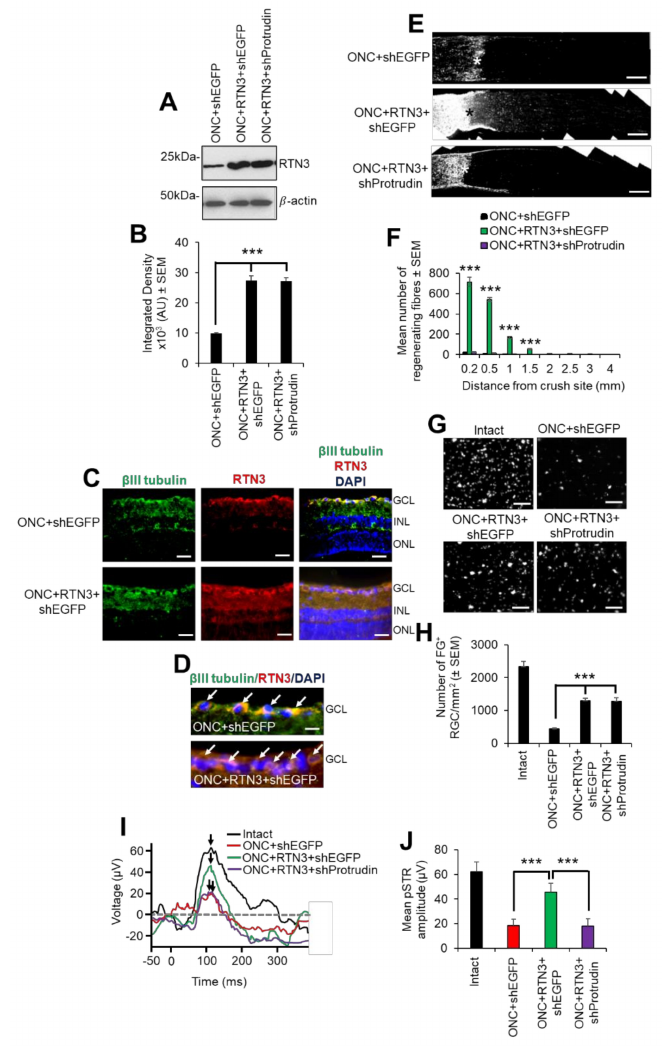
Figure 8. RTN3 overexpression promotes RGC axon regeneration and functional recovery after ONC, which is also protrudin-dependent. ( A ) Western blot and ( B ) quantification to show that RTN3 plasmids significantly upregulate RTN3 protein in the retina after intravitreal injection in vivo. ( C ) Immunohistochemistry to localise RTN3 protein to the RGCs (green) in the ganglion cell layer (GCL) and the inner plexiform and inner nuclear layer (INL). ONL = outer nuclear layer. ( D ) High power images to show RTN3 protein localised to β III-tubulin + RGCs (arrows) in the GCL. ( E ) GAP43 immunohistochemistry and ( F ) quantification to show that in control optic nerve, few if any GAP43 + axons pass beyond the lesion site (*) whilst in RTN3 overexpressed eyes, significant GAP43 + axons are present beyond the lesion site, an effect which is obliterated when Protrudin is knocked out at the same time as RTN3 overexpression. ( G ) Representative images to show FluorGold (FG) backfilled RGC in retinal wholemounts after RTN3 overexpression. ( H ) Quantification of the number of FG + RGC in retinal wholemounts shows that overexpression of RTN3 is significantly neuroprotective, an effect that is independent of protrudin. ( I ) Representative ERG traces and ( J ) quantification of the pSTR amplitude shows significant improvements in RTN3 overexpressed eyes which are ablated after protrudin knockdown. Arrows show the peak of the pSTR. Data are means ± SEM. n = 12 eyes/optic nerves/treatment. Scale bars in ( C ) = 100 µ m, scale bars in ( D ) = 25 µ m, scale bars in ( E ) = 200 µ m, scale bars in ( G ) = 50 µ m. *** p = 0.0001, one-way ANOVA with Dunnett’s post hoc